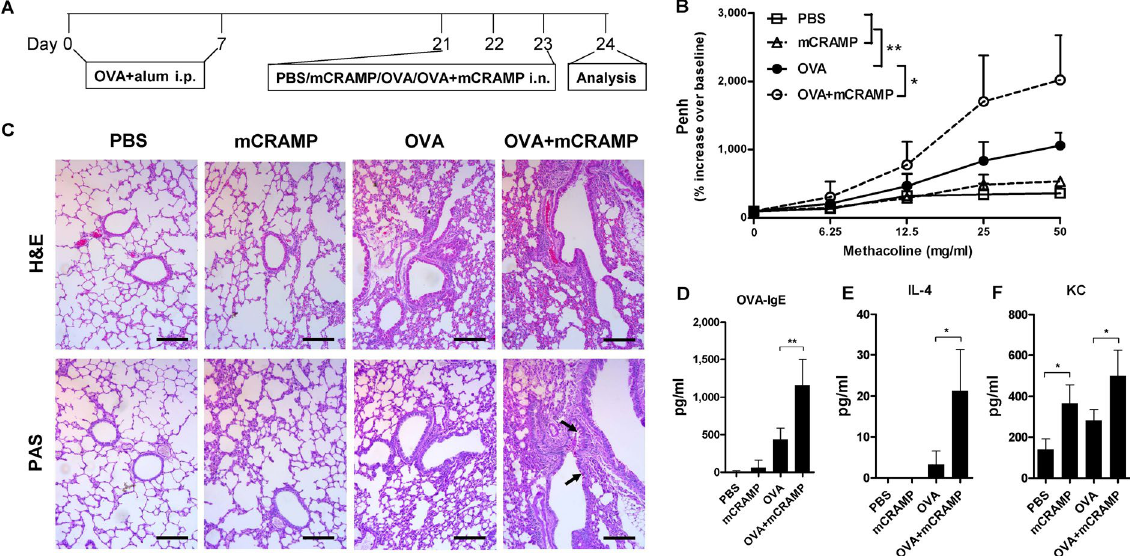
Figure 8. Intranasal administration of mCRAMP induced the exacerbation of OVA-induced airway hyperresponsiveness. ( A ) timeline protocol (Day 0 to Day 24) of OVA-induced allergic airway inflammation and intranasal mCRAMP administration. ( B ) increasing doses of inhaled methacholine-induced airway obstruction were presented as Penh (% increase over baseline), which was calculated by dividing the Penh value of different doses of methacholine by the Penh value of PBS baseline. ( C ) representative H&E and PAS staining of lung sections (x100 magnification). Black arrows denote bright purple-stained mucin-producing goblet cells. Scale bars = 100 µ m. The concentrations of serum OVA-specific IgE ( D ) as well as IL-4 ( E ) and KC ( F ) in the lung homogenates were determined. * P < 0.05, ** P < 0.01 . Data are representative from 2